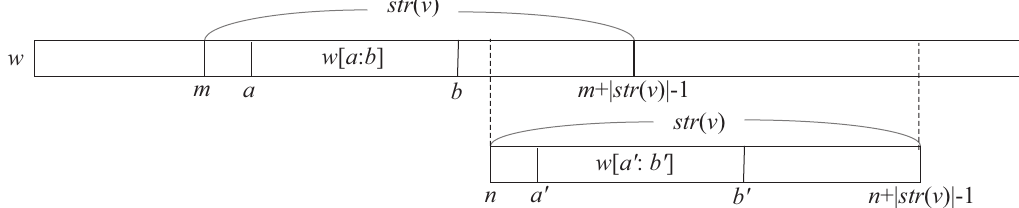
Figure 6. Illustration of proof for Lemma